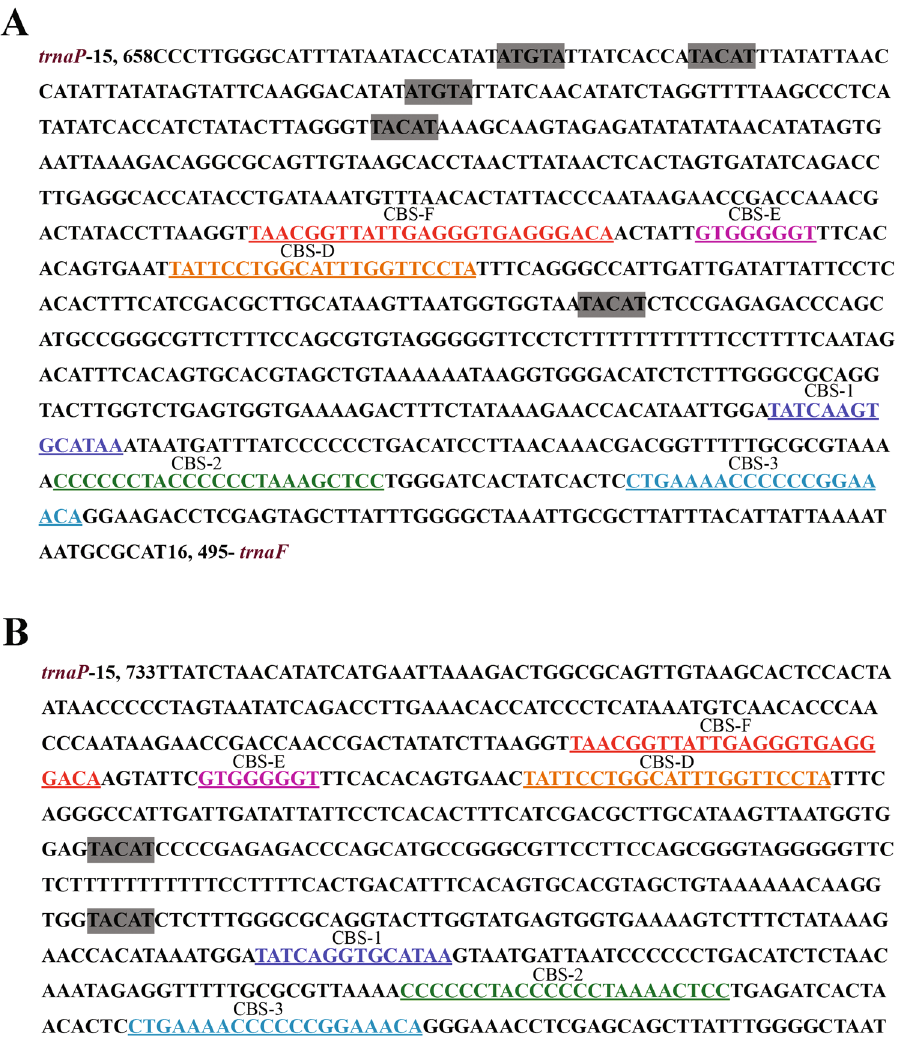
Figure 6. Features present in the control regions of the C. kumu ( A ) and L. microptera ( B ) mitogenomes. The conserved sequence blocks contain CSB-F (red), CSB-E (purple), CSB-D (orange), CSB-1 (deep blue), CSB-2 (green) and CSB-3 (light blue). The conserved motifs ATGTA and its complement TACAT which may form thermostable hairpin structure are Non-coding regions. Except for the several short non-coding regions between genes, there are also two long non-coding regions in the mitochondrial genomes of C. kumu and L. microptera : O L and CR, which are important in the transcription, replication and maintenance of the mitochondrial genome 41 . In mitogenomes of C. kumu and L. microptera , O L is found in the domain between trnN and trnC, which is folded a hairpin secondary struc- ture (Fig. 5). The length of C. kumu is 36 bp in C. kumu and 38 bp in L. microptera , respectively. The control region is essential for the initiation of replication in vertebrates, which is found between tRNA Pro and tRNA Phe . The CR in C. kumu spanned 838 bp with a 60.8% A + T content and shows an equal AT skew (0) and a negative GC skew ( − 0.0793). The CR in L. microptera spanned 838 bp with 59.3% A + T content and shows a slightly positive AT skew (0.0181) and a negative GC skew ( − 0.1144). The A + T content of the two mitogenomes is lower than most of the other Scorpaeniformes species to date 33, 34 . Several conserved sequence blocks (CSBs) are observed in the control regions of teleost fish, which could play important roles in mitochondrial metabolism 42 . In CR of teleost fish, CSB-D, -E and -F are found in central conserved domains. Meanwhile, CSB-1, CSB-2 and CSB-3 are typically present in the conserved sequence block domain 42 . All the CSBs are identified in C. kumu and L. microptera , by comparing them with the recognition sites in Scorpaeniformes species (Fig. 6). Both species have no relatively similar repetitive motifs in the control regions, which indicated that the repeat motifs occurred after family diver- sification. However, more information is necessary to further evaluate evolutionary aspects of repeat clusters. In addition, tandem repeats are not found in the two species using the Tandem Repeats Finder program 25 . This phenomenon exists for other Scorpaeniformes species with the exception of the genus Sebastes 33, 34 .